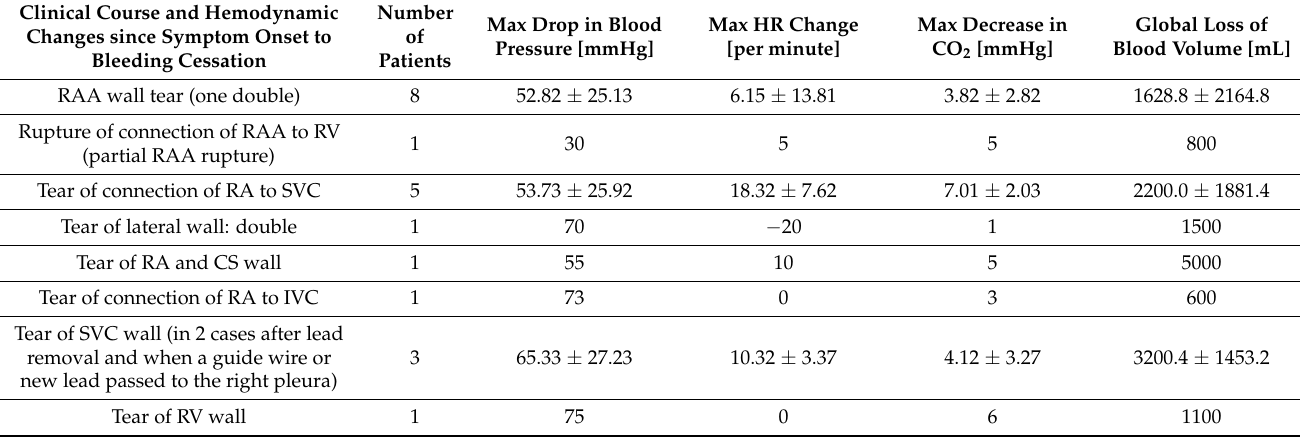
Table 5. Description of the symptoms of cardiac and vascular damage during